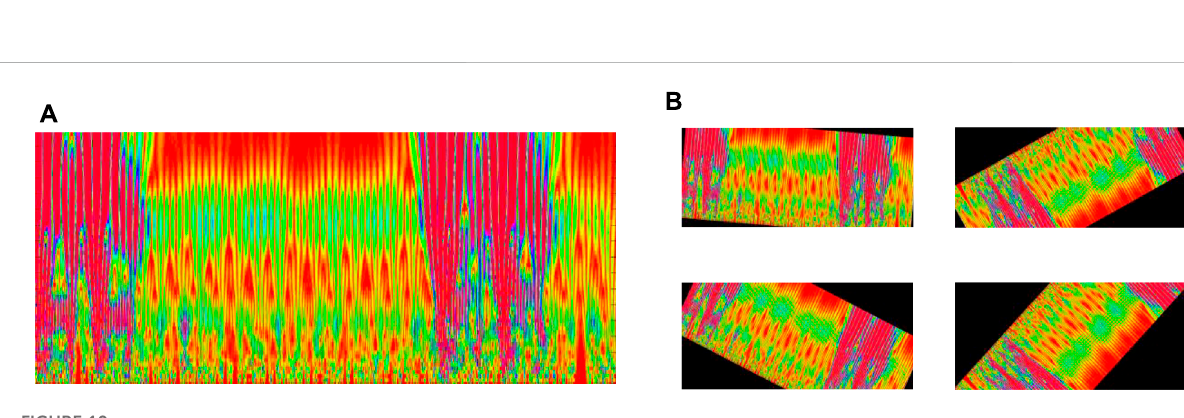
FIGURE 10 Random Angle changes of the image, (A) is the original image, (B) is the changed image.